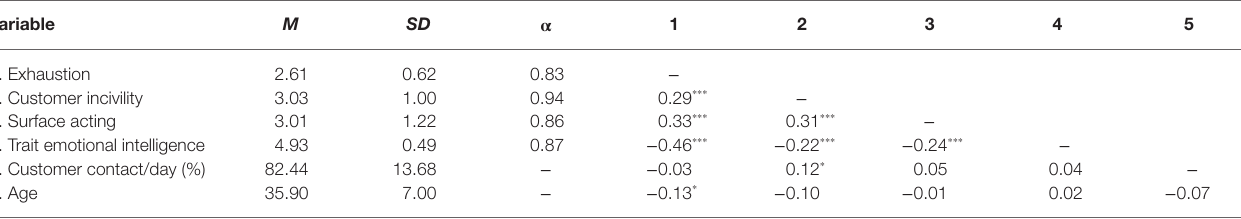
TABLE 3 | Study 2 means, standard deviations, intercorrelations, and internal-consistency reliability (Cronbach’s α ) of study variable. Variable M SD α